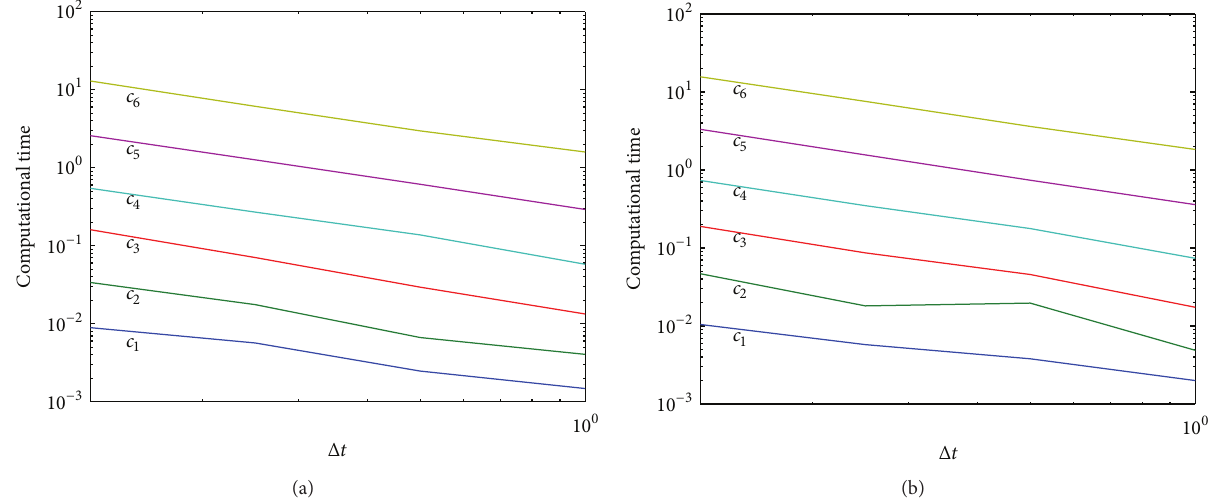
Figure 10: The computational time of the one-sided and two-sided splitting schemes for an optimised approach: one-sided splitting over 𝐴 (a) and two-sided splitting scheme alternating between 𝐴 and 𝐵 (b) with 1,...,6 iterative